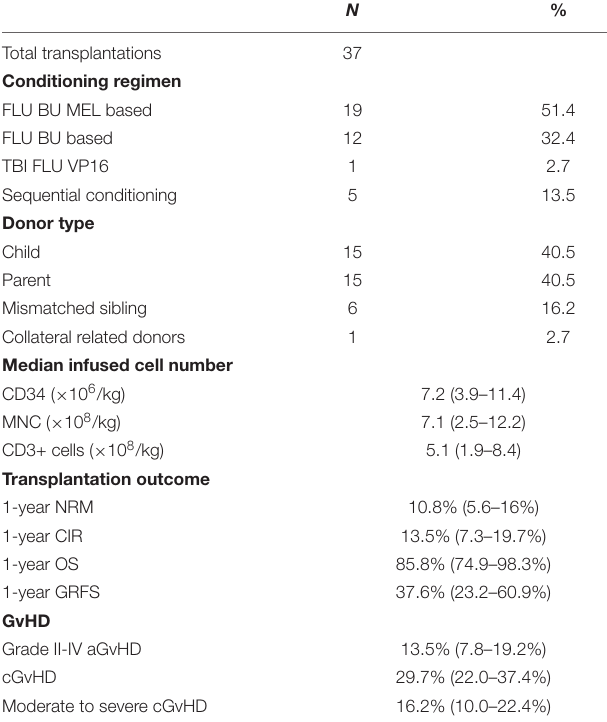
TABLE 2 | The summary of transplants and clinical